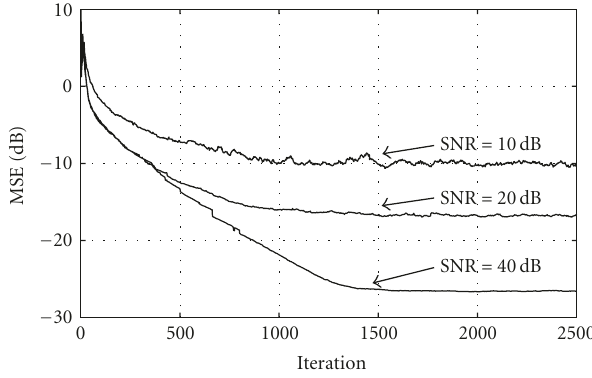
Figure 9: MSE e 2 [ n ] on the Wiener system’s internal signal r [ n ] for r various noise levels, obtained by the adaptive KCCA algorithm.